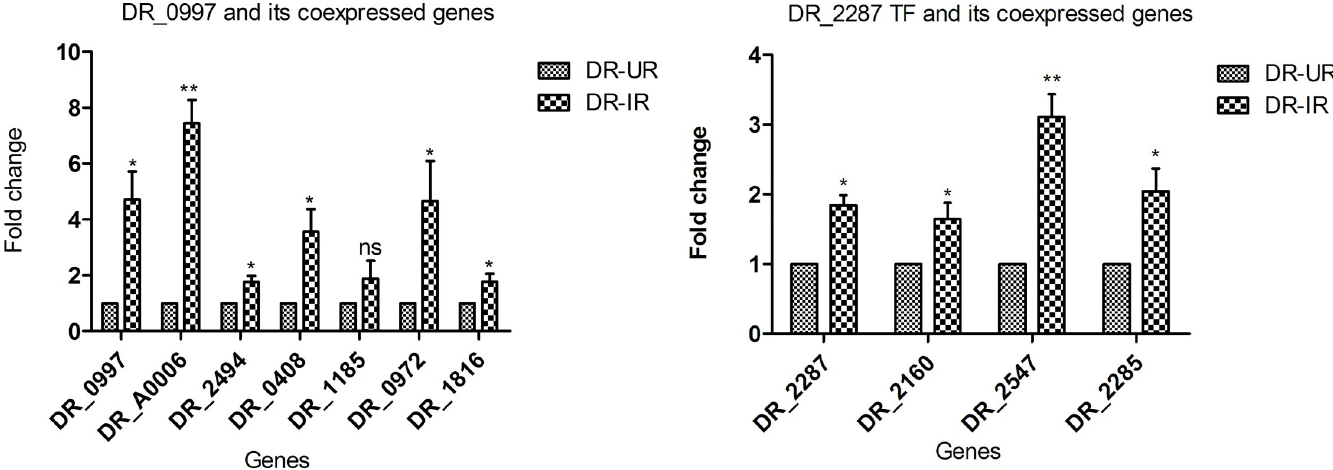
Fig 6. Bar graph of qRT-PCR of selected TFs and their first neighbors in radiation stress associated module. Expression profiles of direct or close neighbors of TF (A) DR_0997 and (B) DR_2287 in a darkgreen module at 90 minutes of PIR (Radiation dose-6 kGy) in WT D . radiodurans . Error bars indicate Mean ± SD. � p value � 0.05, �� p value �